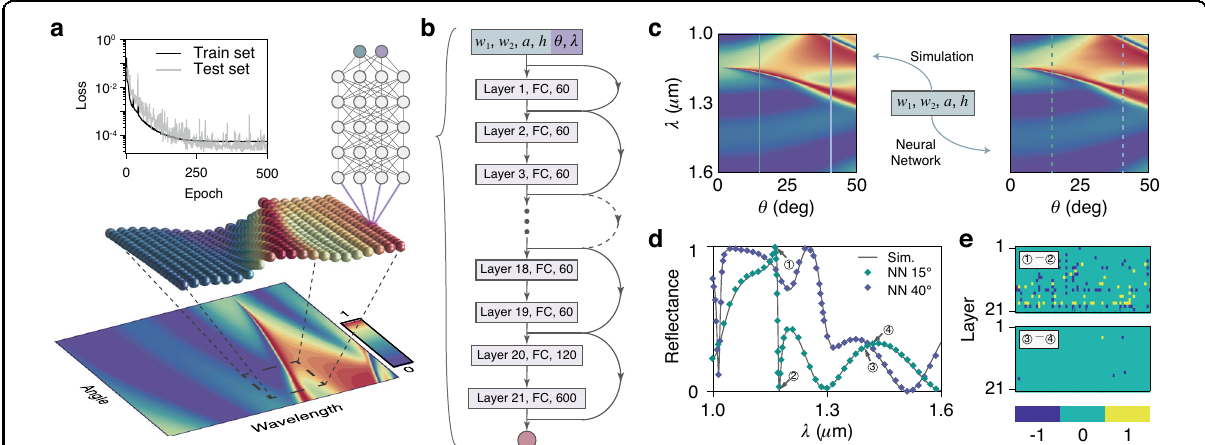
Fig. 2 Architecture and performance of the forward-mapping NN. a Generation process and its training loss (inset). b Parameters-to-point architecture of the forward-mapping NN. c Comparison between the simulated (left) and NN-generated (right) dispersions of the SOI grating. Geometric parameters of SOI grating: w 1 = 215 nm, w 2 = 235 nm, a = 500 nm, h = 256 nm. Here, we just show the generated dispersion with s-polarized incident light, and that with p-polarization is shown in Fig. S4. d The simulated (black lines) and NN-generated (squares) dispersions are sliced at 15° and 40° for detailed comparisons. We lowered the sampling frequency of the generated dispersions for a better demonstration. Both of the sliced spectra contain at least one Fano-shaped feature. e Changes in the states of activation of neurons when NN generates two neighboring points of the re fl ectance in the